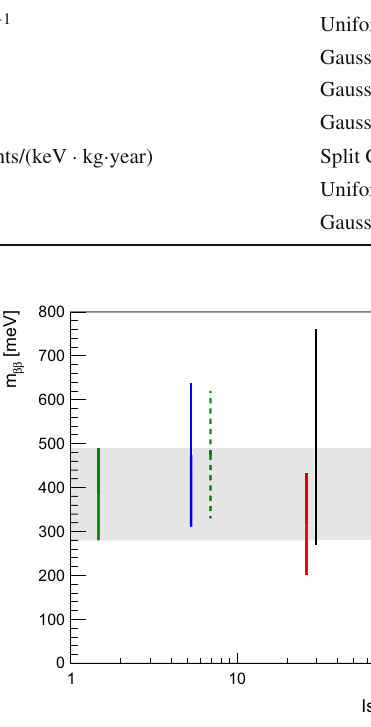
(cid:3) (cid:2) Fig. 17 Published m ββ values as a function of isotopic exposure for several experiments [14–17,20–22,70]. While each experiment has uti- lized different sets of nuclear matrix elements, the published results represent a standard set of values we can compare this work’s result to. The spread for CUPID-Mo results is shown with a band for illustrative (cid:2) (cid:3) m ββ purposes only, indicating the range as it relates to other experi- ments more clearly and showing the promise of this technology with only a relatively modest isotopic